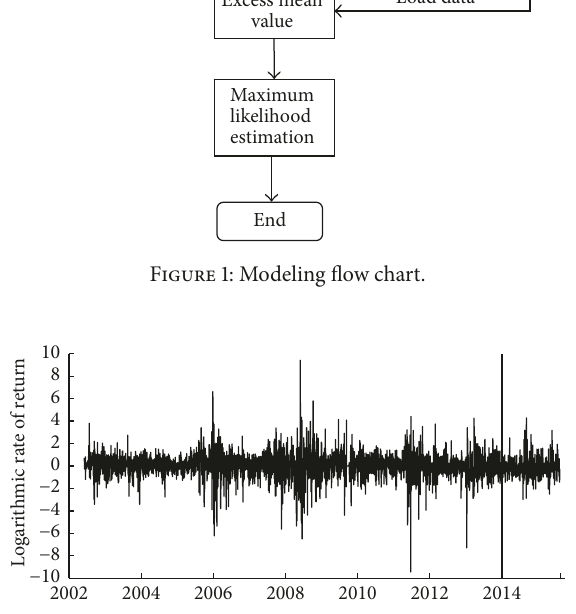
Figure 2: Sequence timing diagram of gold price logarithmic earn-